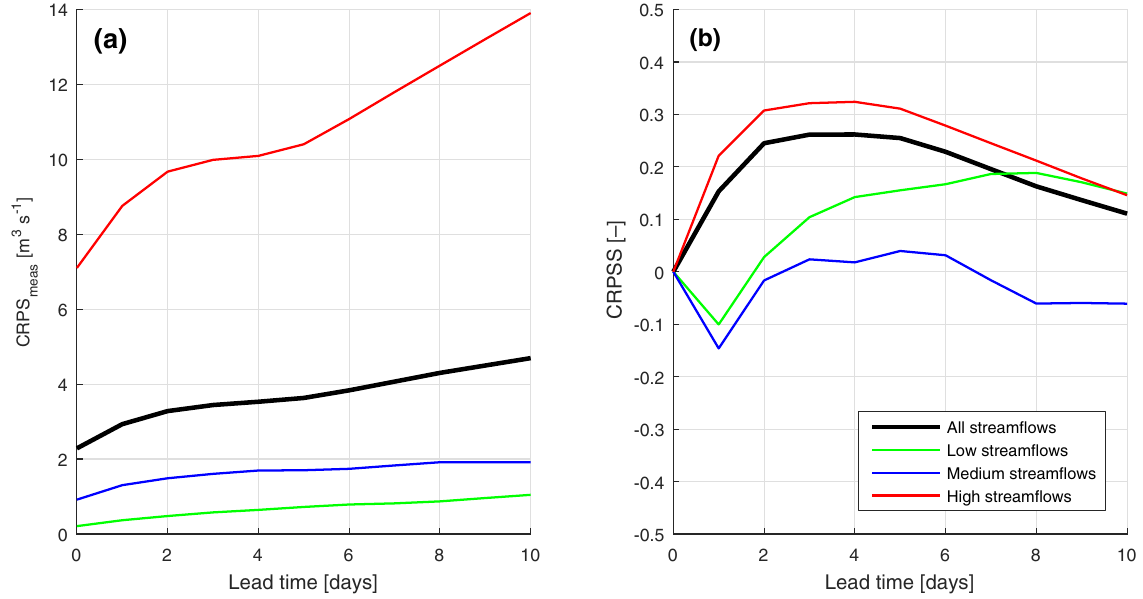
Figure 6. (a) Streamflow forecasts evaluated against streamflow measurements. (b) Skill of the streamflow forecasts, defined in Eq. (1).